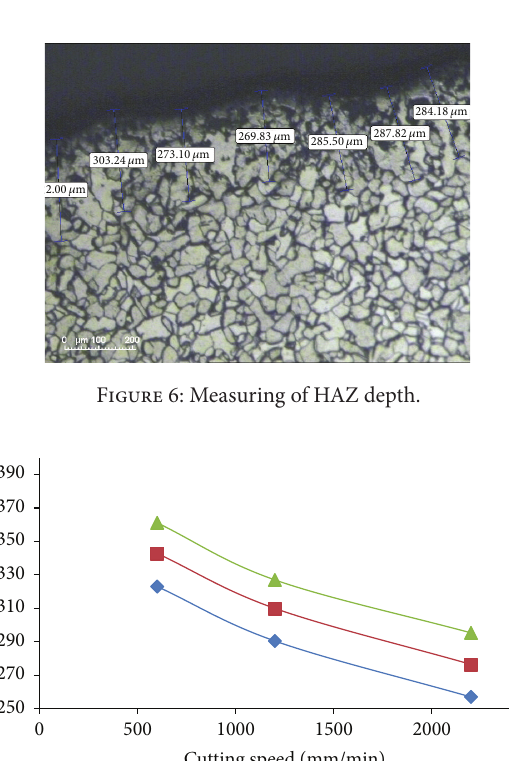
Figure 5: Full view and magnified images of cut surface microstructure.